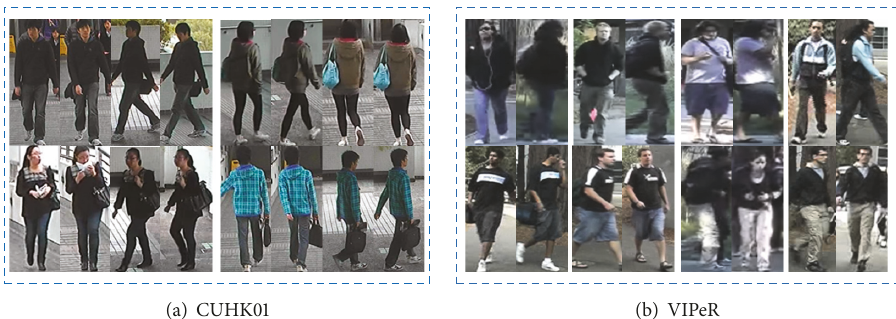
Figure 1: Samples of pedestrian observed from CUHK01 and VIPeR datasets. The same person’s appearance change in different camera views.